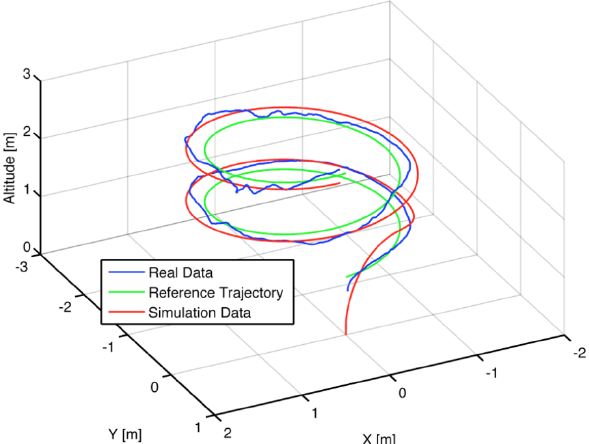
Figure 9. 3D simulated and real response for path following of the AR.Drone 2.0 using EPSAC-MPC on ( X, Y and Z ) degrees of